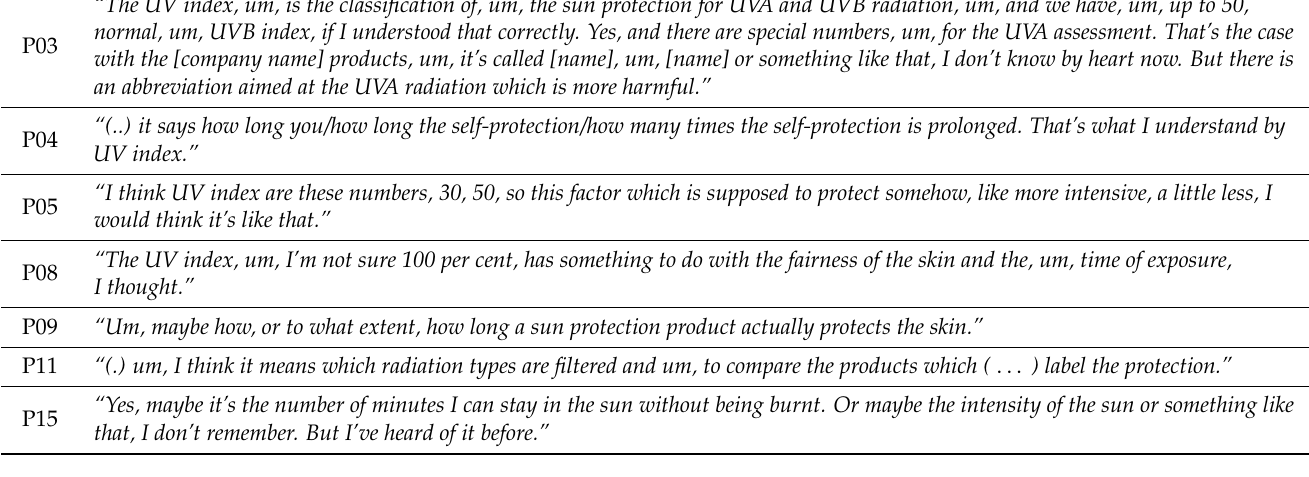
Table 2. Incorrect definitions of the UV index given by pharmacists and pharmaceutical technicians.